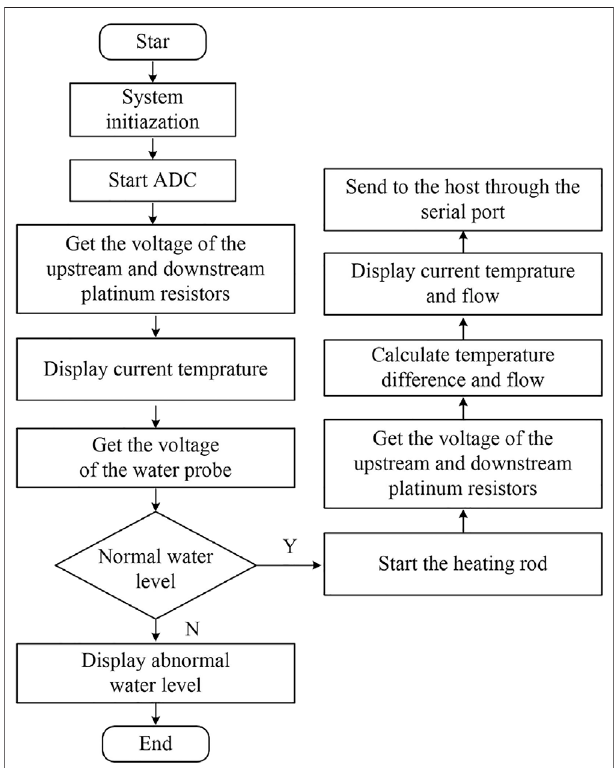
FIGURE 5 | System program fl ow chart.